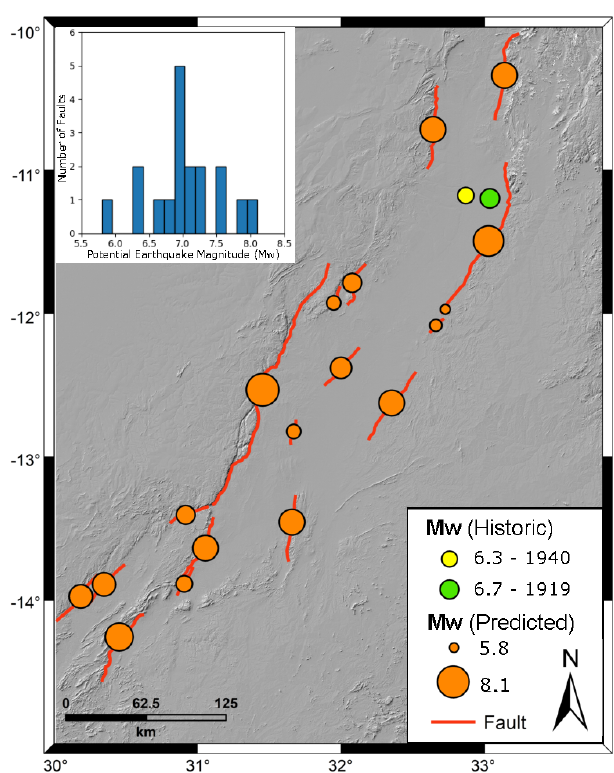
Figure 8. Hillshade map of the Luangwa Rift showing estimated maximum earthquake magnitudes for each fault (orange circles) alongside previous recorded seismicity. Inset shows a histogram of maximum potential magnitudes (estimated using empirical relation- ships between fault length and earthquake magnitude), which range from M w 5.8–8.1.